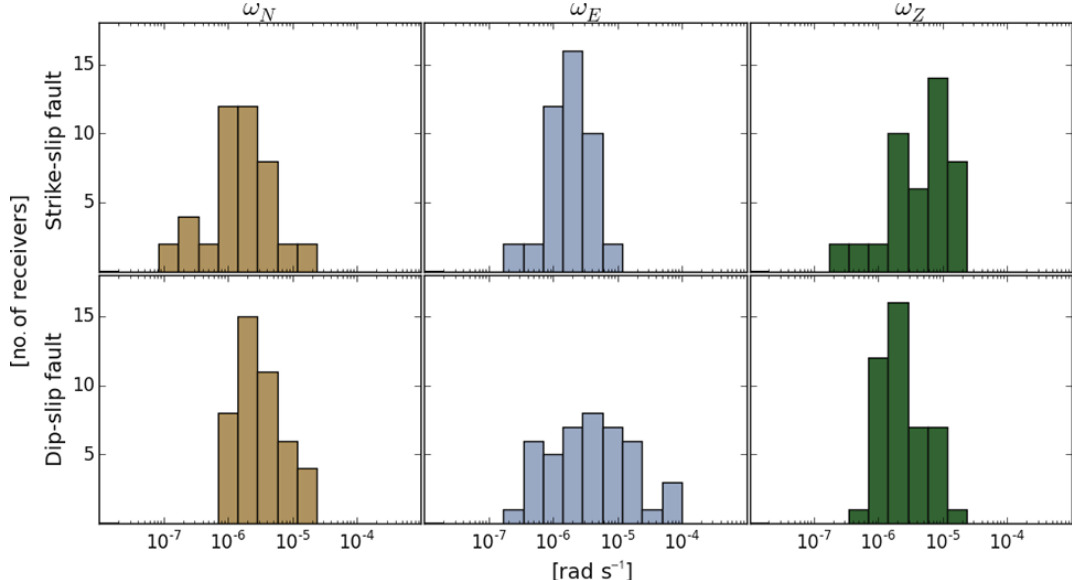
Figure 9. Histograms for maximum amplitudes of the three rotation components at all stations. The top row shows the distribution for the strike-slip fault, the bottom row for the dip-slip fault. The logarithmic scale for the rotation rates helps to get a sense for the amplitudes’ order of magnitude. The histograms show how all 44 maximum amplitude values (for all 44 receivers) range between 10 − 7 and 10 − 4 rads − 1